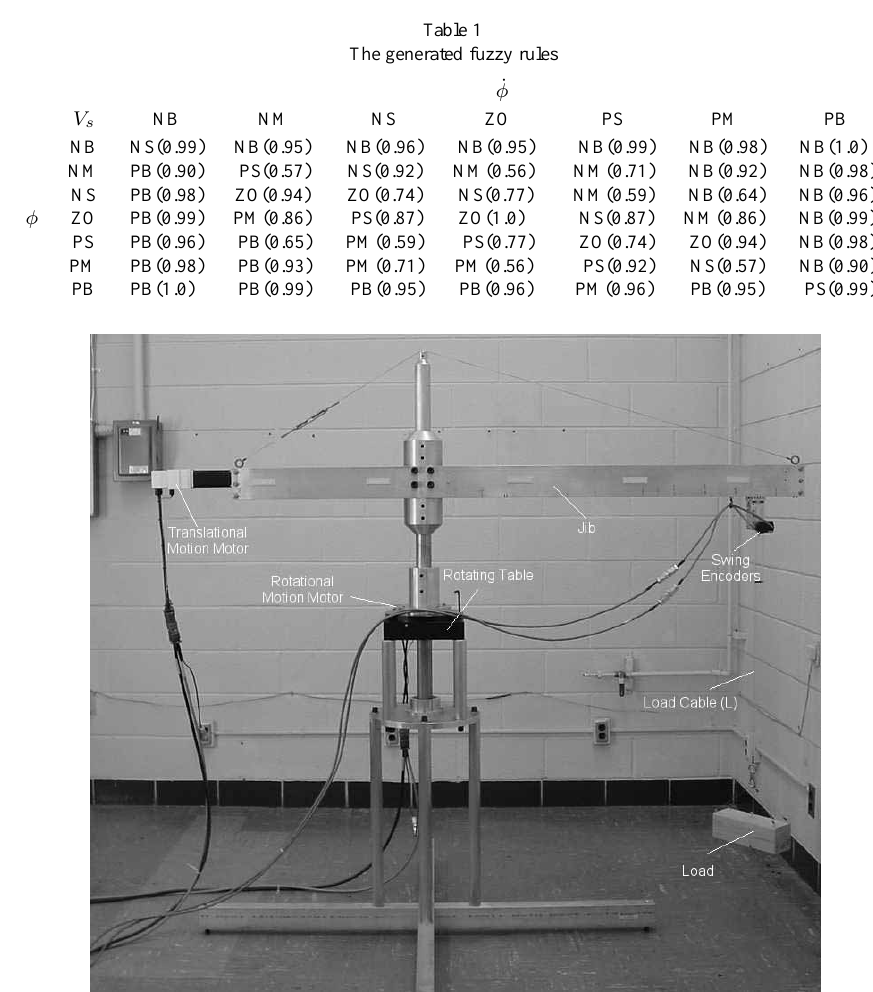
Fig. 11. The tower-crane model used in the